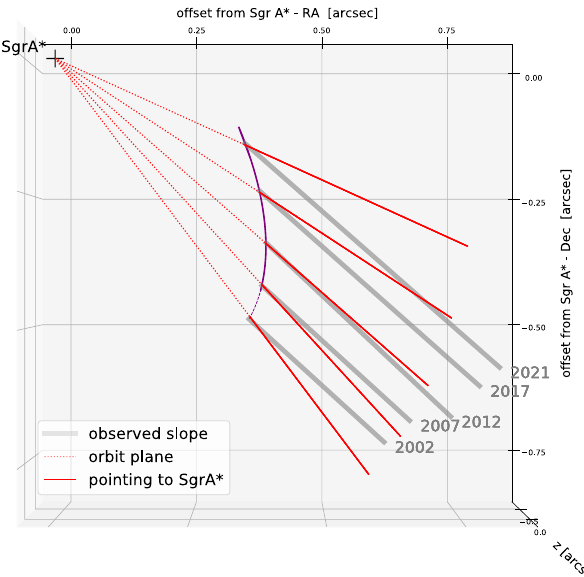
Figure 12. The X7 tail does not point to Sgr A * . Red lines show the expected tail orientation on the sky if it always points toward Sgr A * and is in the plane of the feature ’ s orbit, while the thick gray lines show the observed constant